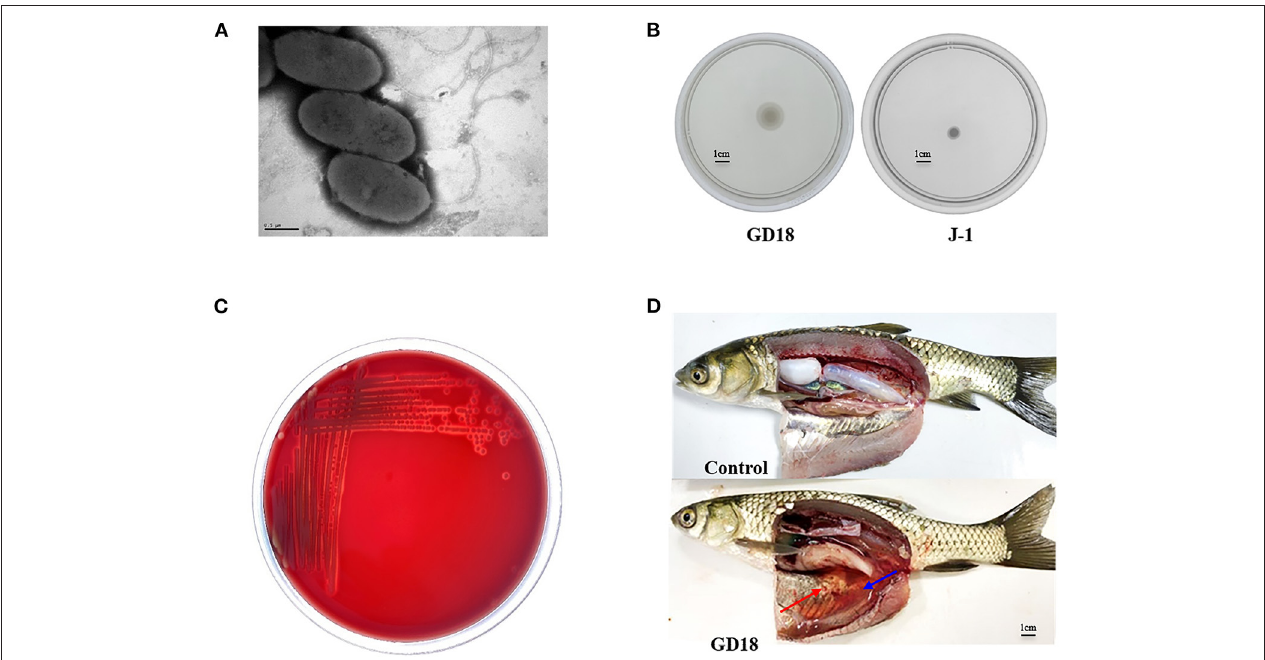
FIGURE 1 | Biological characteristics of A. hydrophila GD18. (A) Morphological characteristics of A. hydrophila GD18 observed under a transmission electron microscopy. (B) Swimming motility of A. hydrophila GD18. (C) The hemolytic activity of A. hydrophila GD18 was confirmed by plating on a blood agar plate. (D) Grass